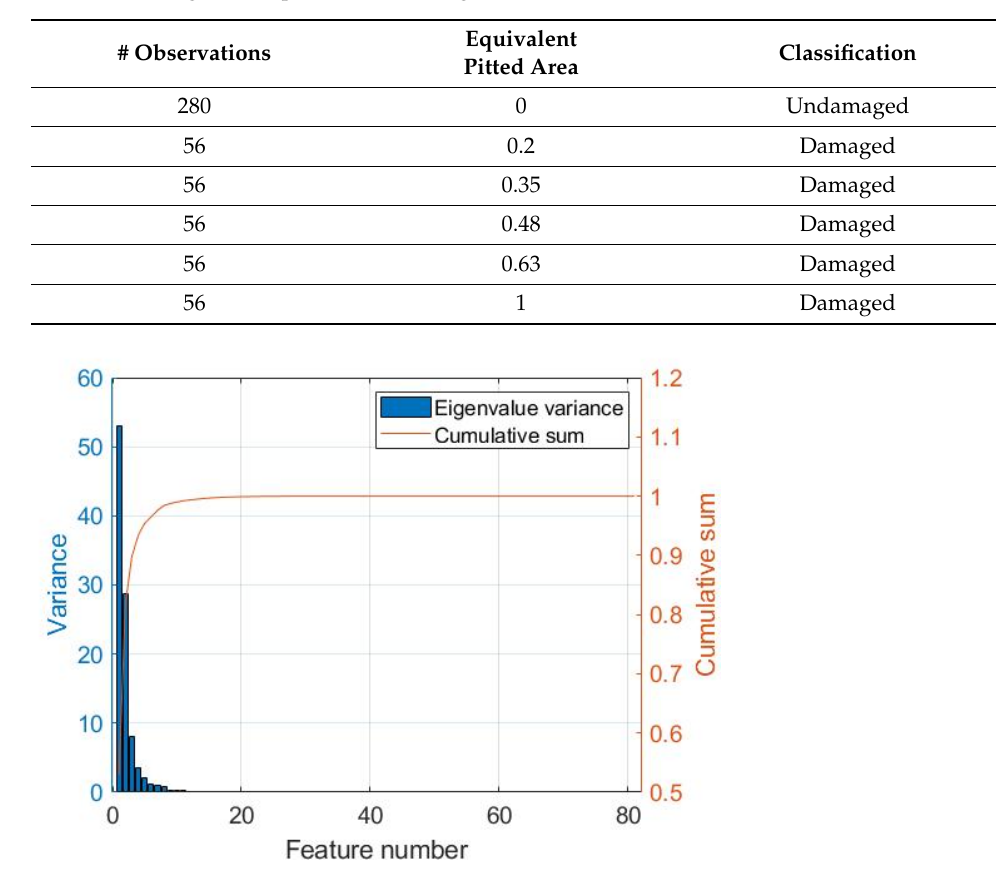
Figure 18. Variance associated with each feature after PCA on the detection dataset and cumula- tive sum.